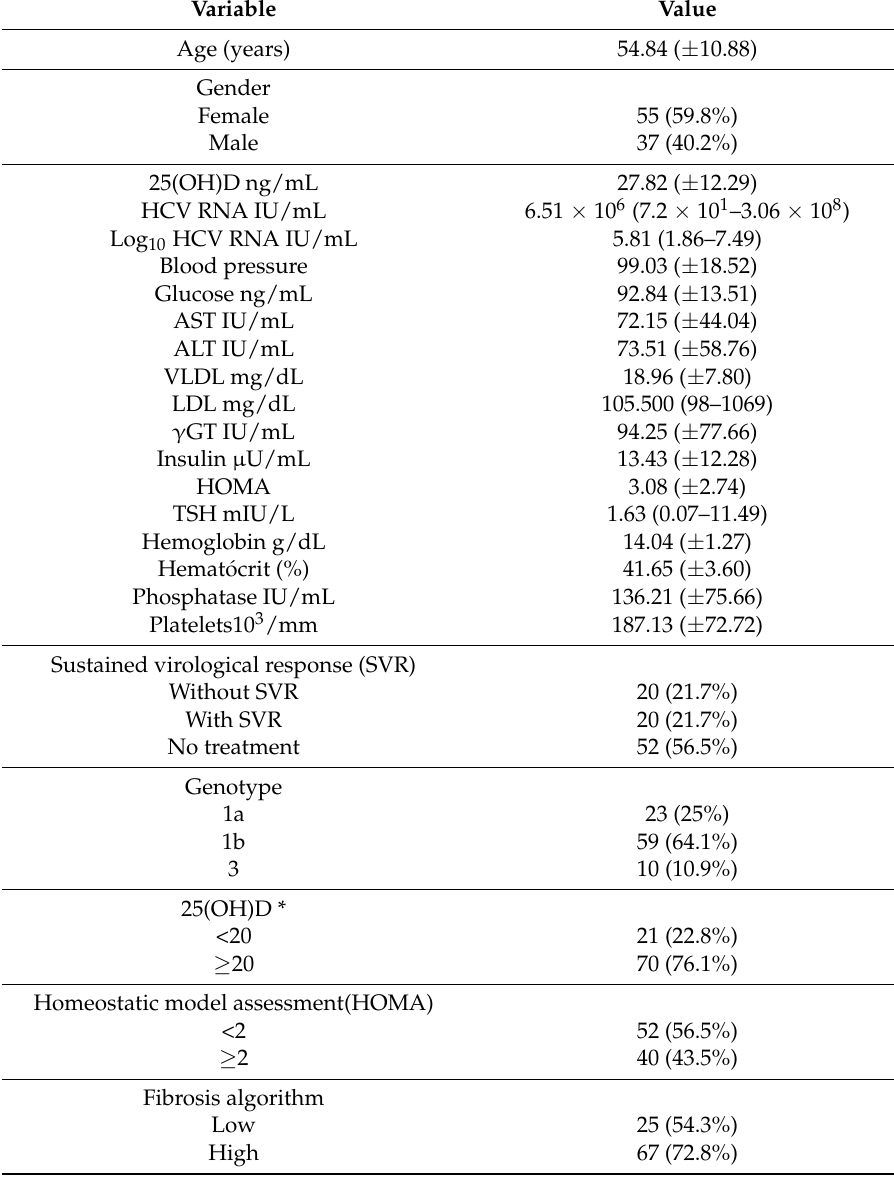
Table 1. Demographic, laboratory, and metabolic data of 92